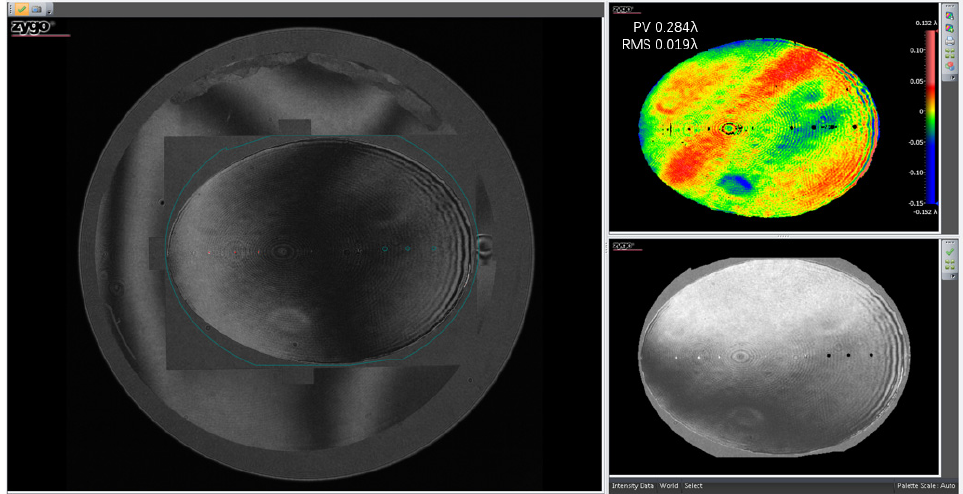
Figure 21. Mirror surface error before the vibration test.